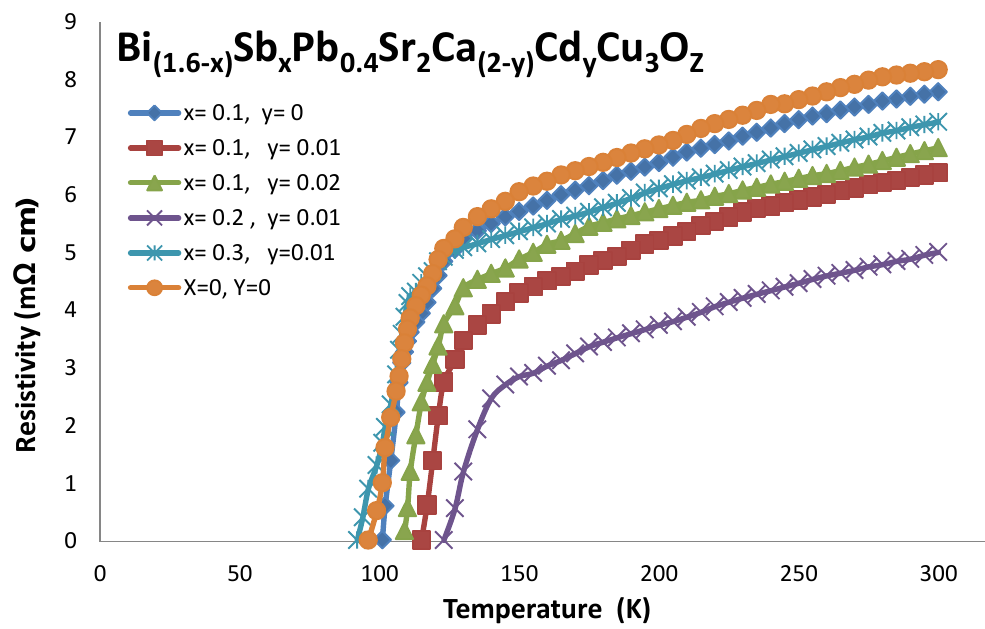
Sb Pb Sr Ca Cd Cu O 1.6-x x 0.4 2 2-y y 3 Z